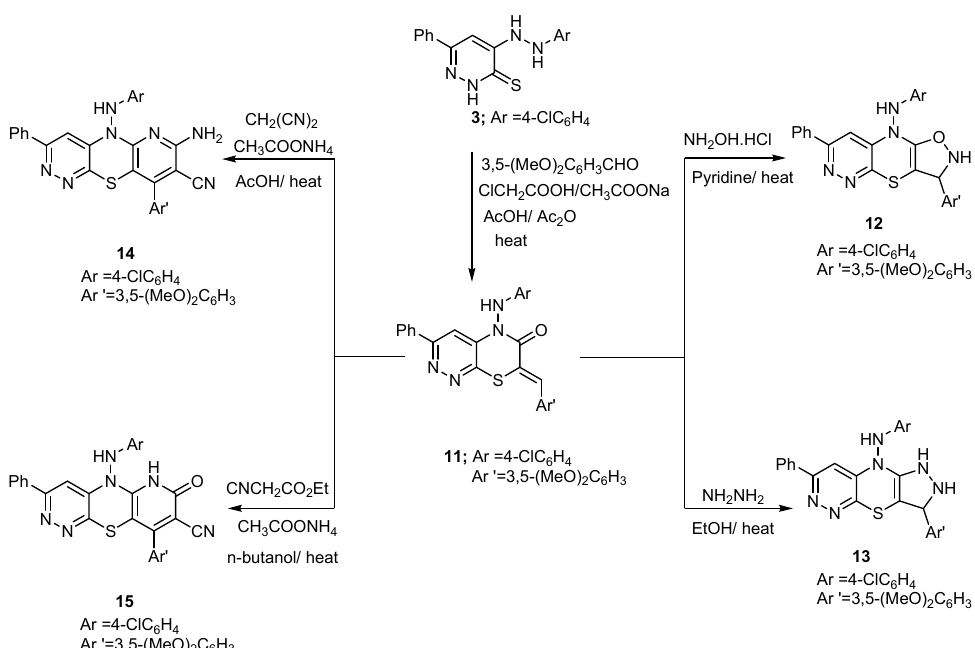
Scheme 3. General methods for preparation of compounds 11 – 15 .